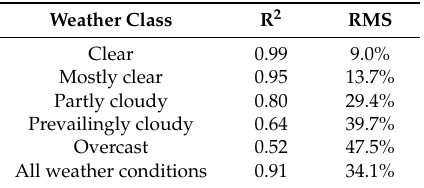
Figure 3. Measured vs. simulated hourly irradiation at −1 ≤ ( wc forecast − wc measured ) ≤ 1(red line is to guide your eyes). Table 3. Simulation errors with regard to the weather class.